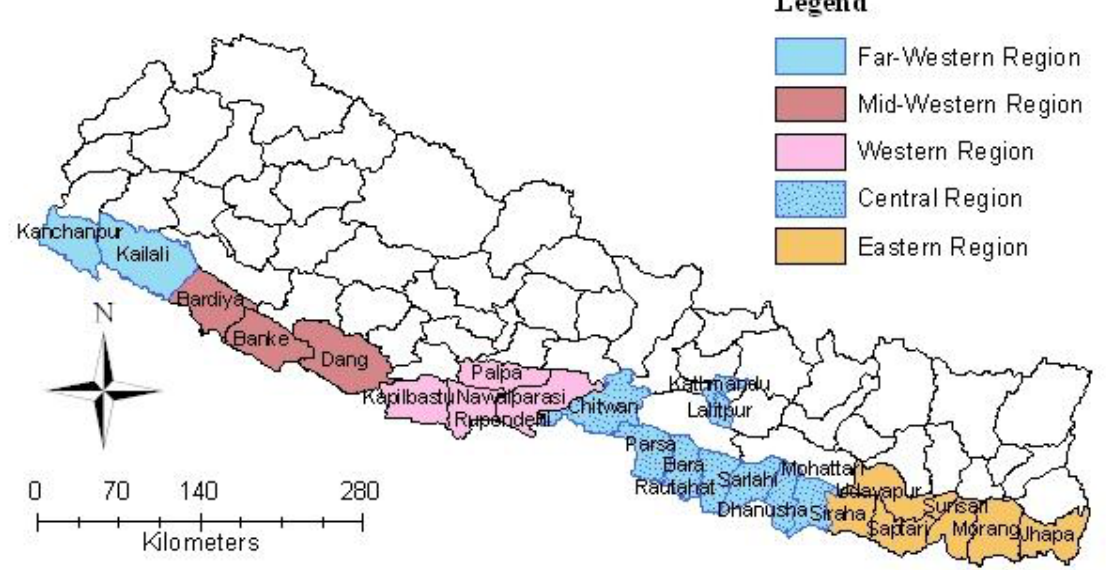
Figure 1. Groundwater arsenic tested districts in various developmental regions of